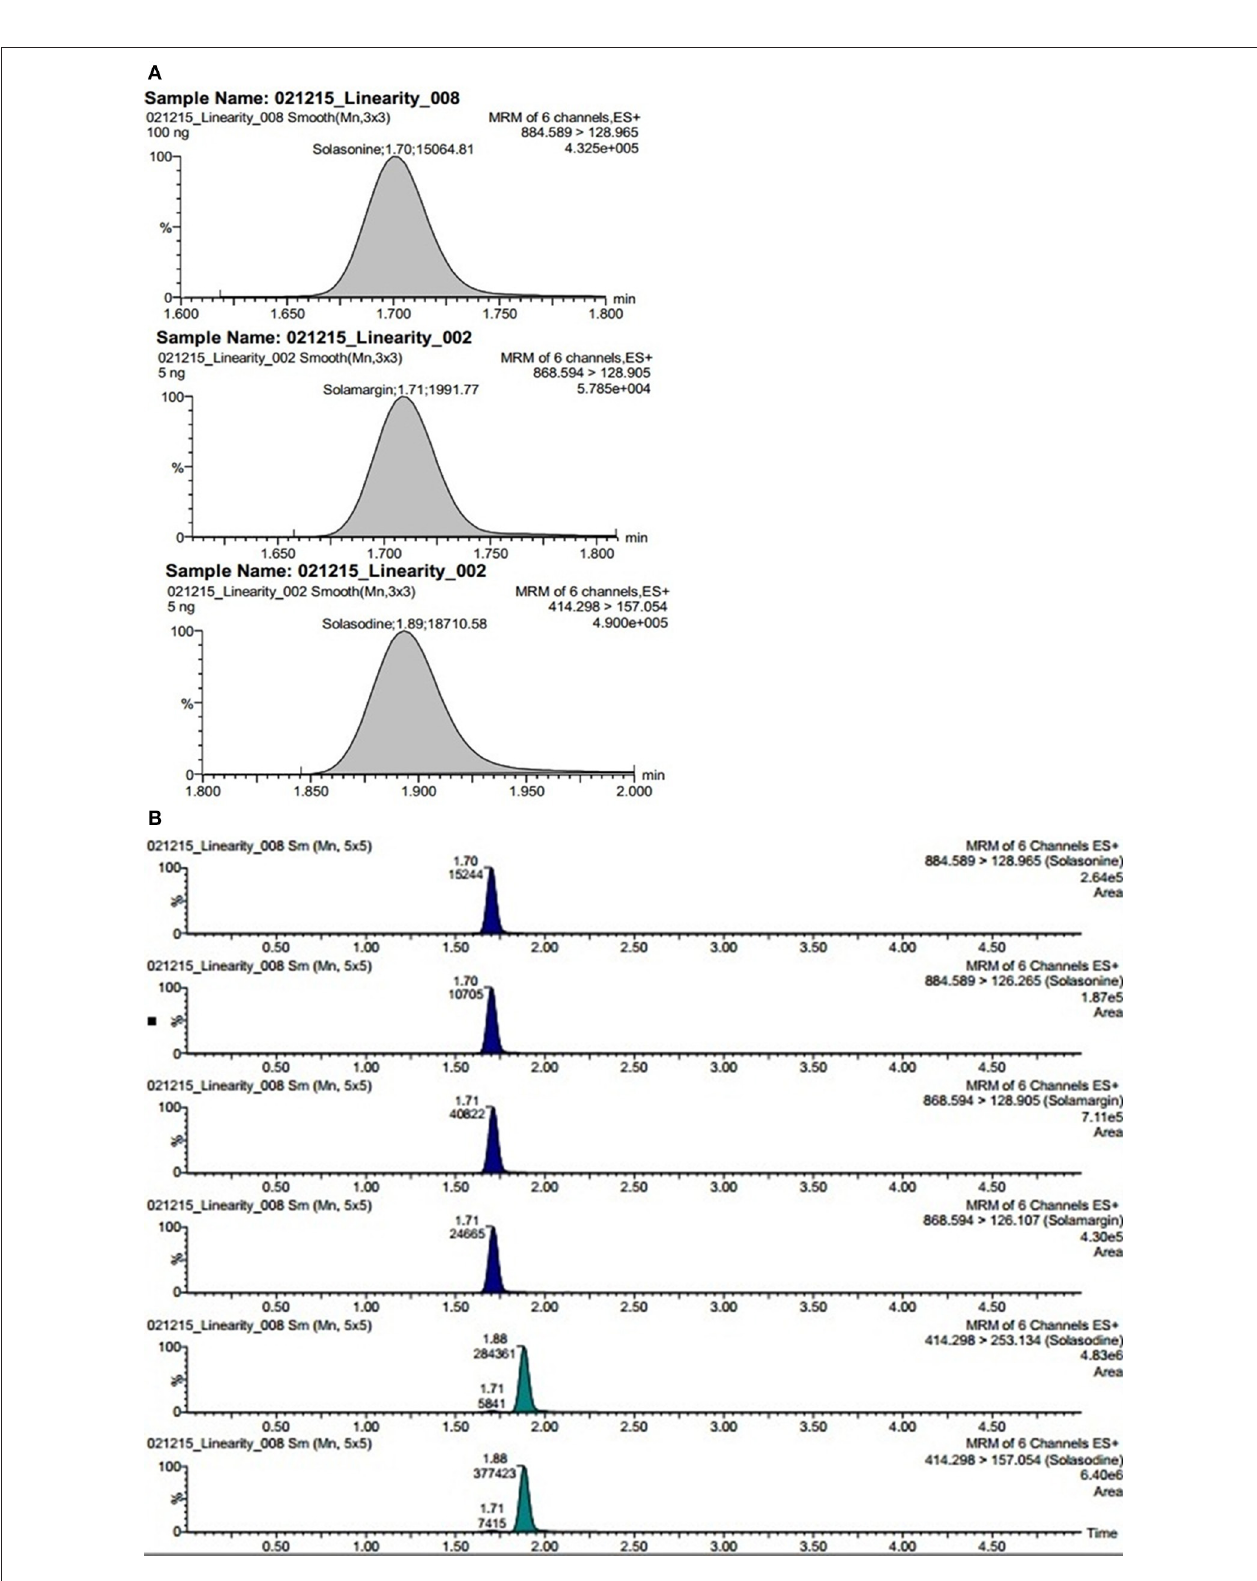
FIGURE 3 | (A) Representative chromatogram showing steroidal glycoside and its aglycone namely solasonine, solamargine, and solasodine. (B) Extracted ion chromatograms of steroidal glycosides namely solasonine, solamargine, and its aglycone solasodine quantified in plant fraction.